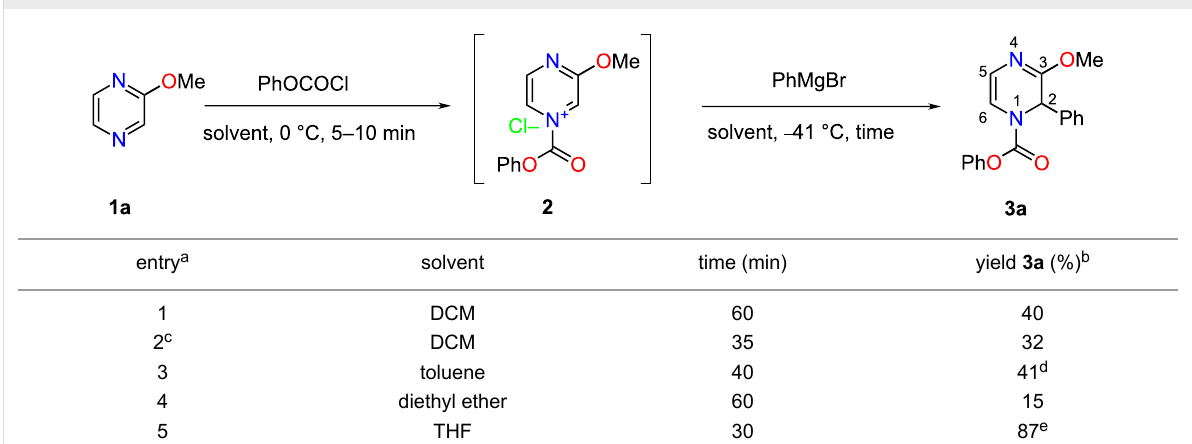
Table 1: Phenyl Grignard addition to methoxy-substituted N -acylpyrazinium